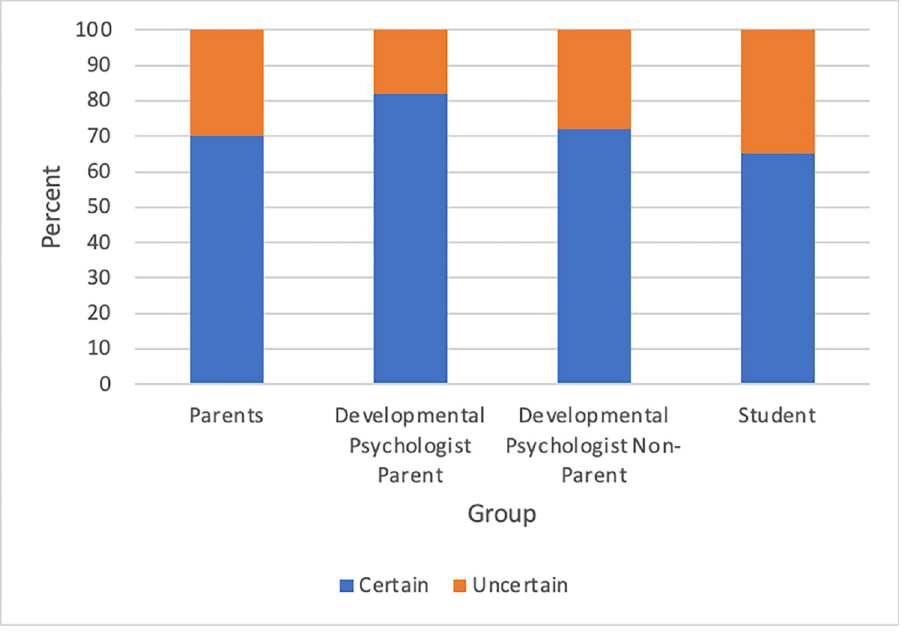
Fig 1. Participant certainty by group.